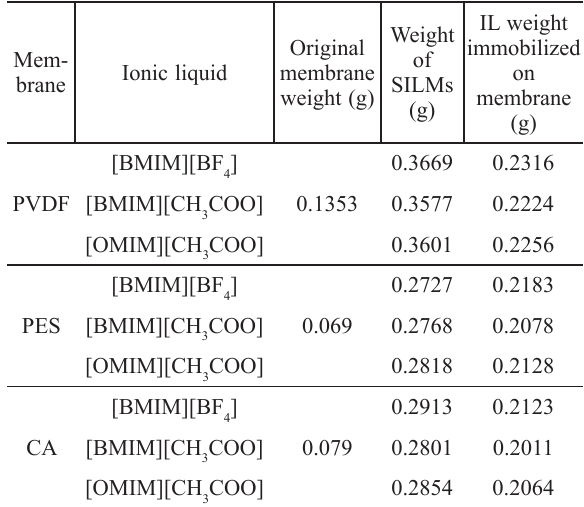
Table 4 – Pore volume of membrane and volume of ionic liq- uids immobilized on polymer membranes Mem- Ionic liquid brane